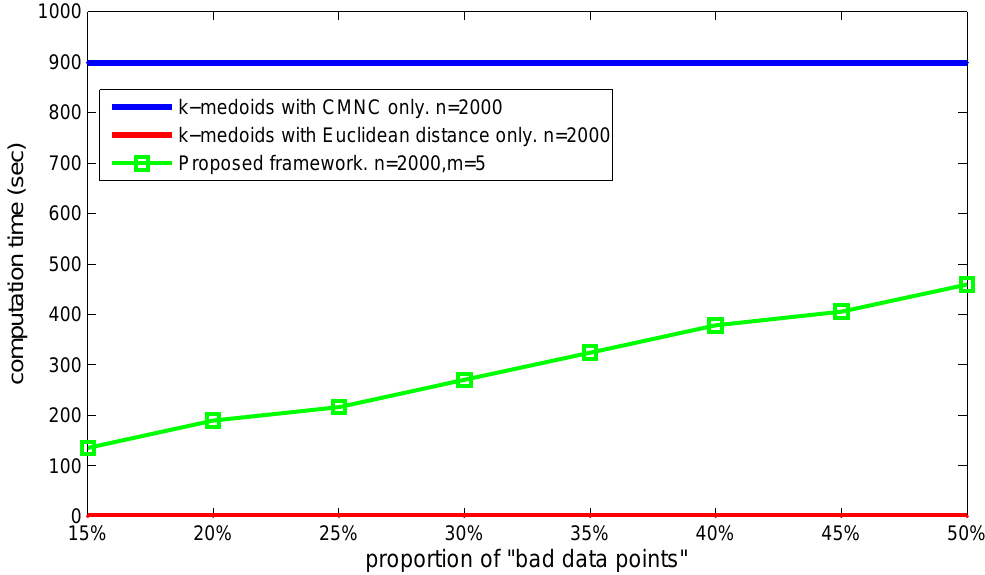
Figure 26. Increase of execution time when the number of the found “bad data points”